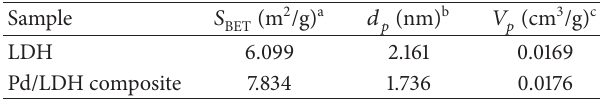
Table 2: Textural properties of LDH and Pd/LDH